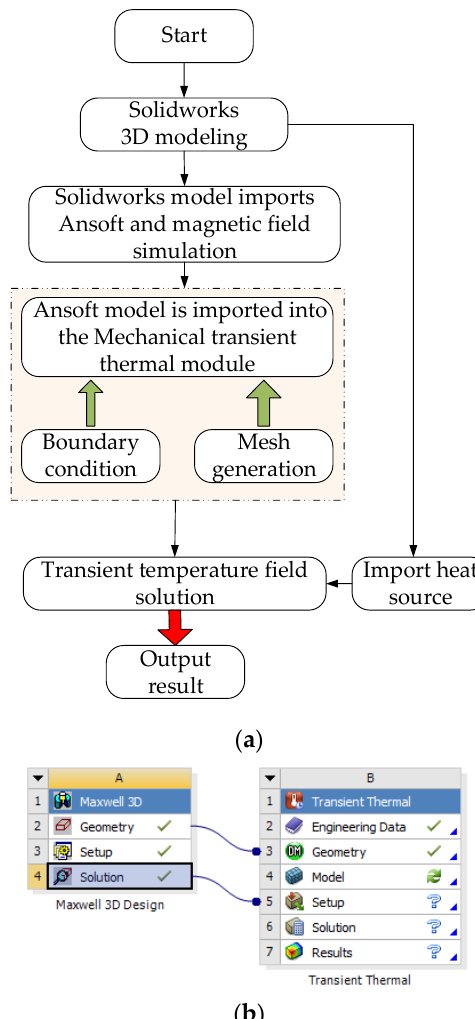
Figure 4. Software Co-simulation: ( a ) Software Co-simulation process; ( b ) Software Co-simulation screenshot.